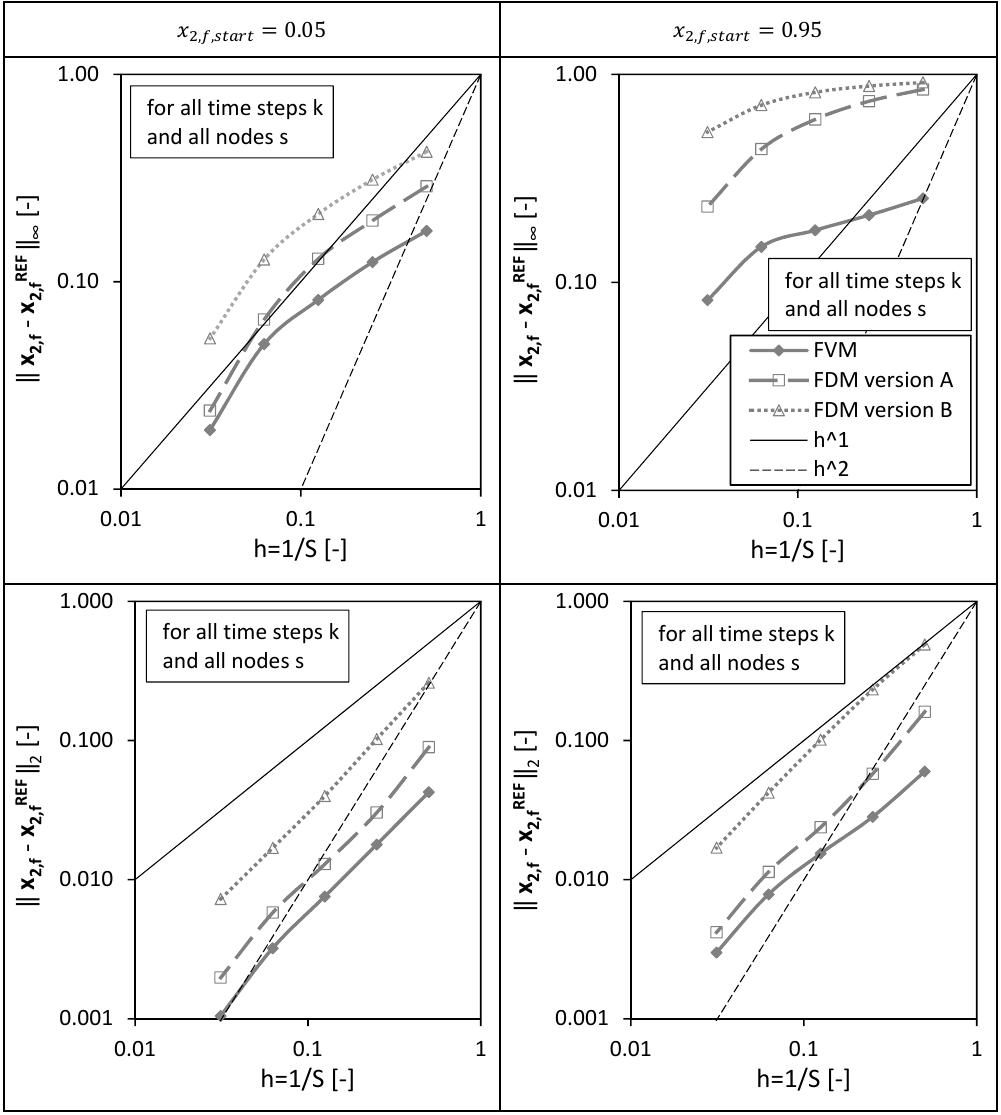
Figure 6. Overall l ∞ and l 2 error calculated for all spatial nodes s and for all drying time steps k for the FVM, FDM version A and B using x (cid:2870),(cid:2916)(cid:2929)(cid:2930)(cid:2911)(cid:2928)(cid:2930) = 0.05 (left panels) and x (cid:2870),(cid:2916)(cid:2929)(cid:2930)(cid:2911)(cid:2928)(cid:2930) = 0.95 (right panels) depending on the reciprocal of the total number of nodes S. Calculation settings: N = 26, S REF = 64, Δ t = 0.05 s (for FVM, FDM version A and B).